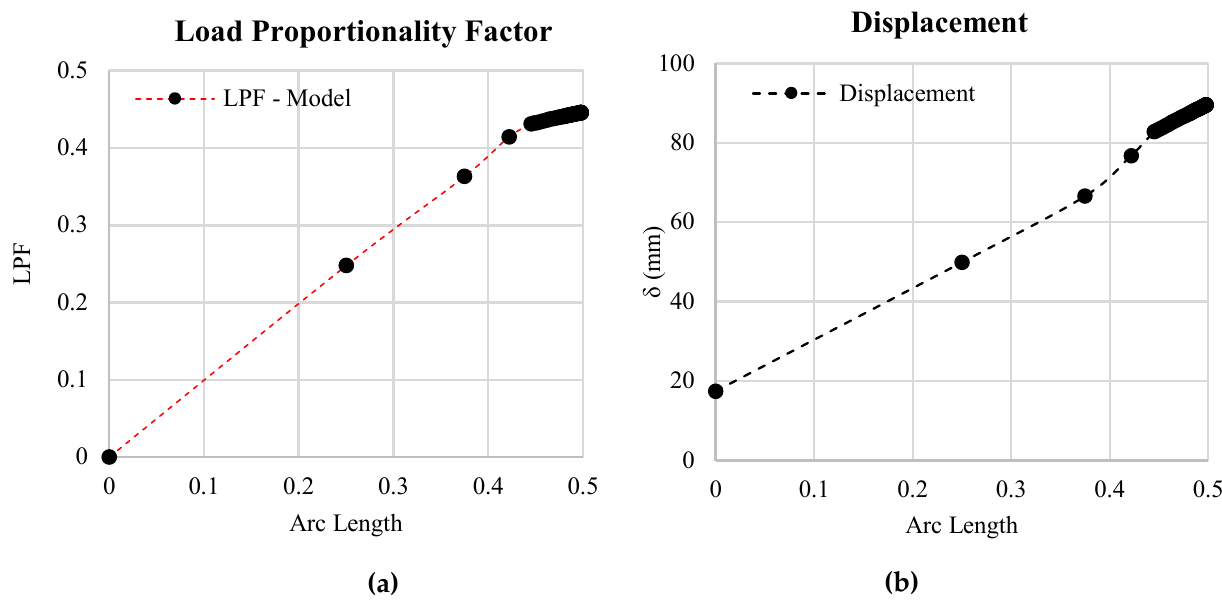
Figure 15. Relationship between Arc length and ( a ) LPF. ( b ) Displacement.